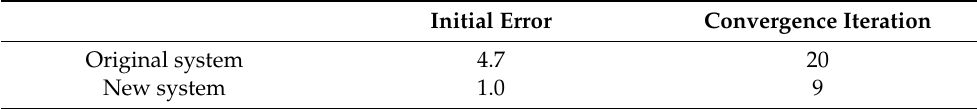
Table 1. Effect of Recombined Experience